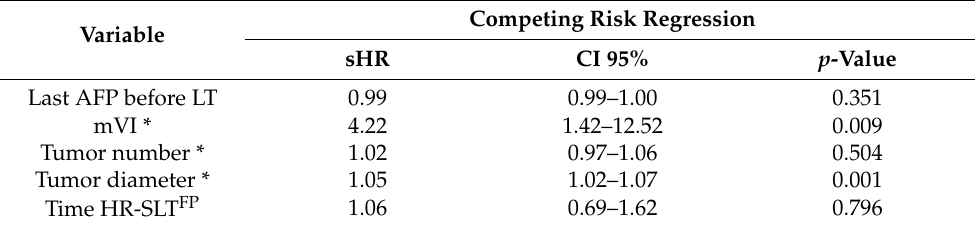
Table 6. Competing risk regression analysis on cancer-related